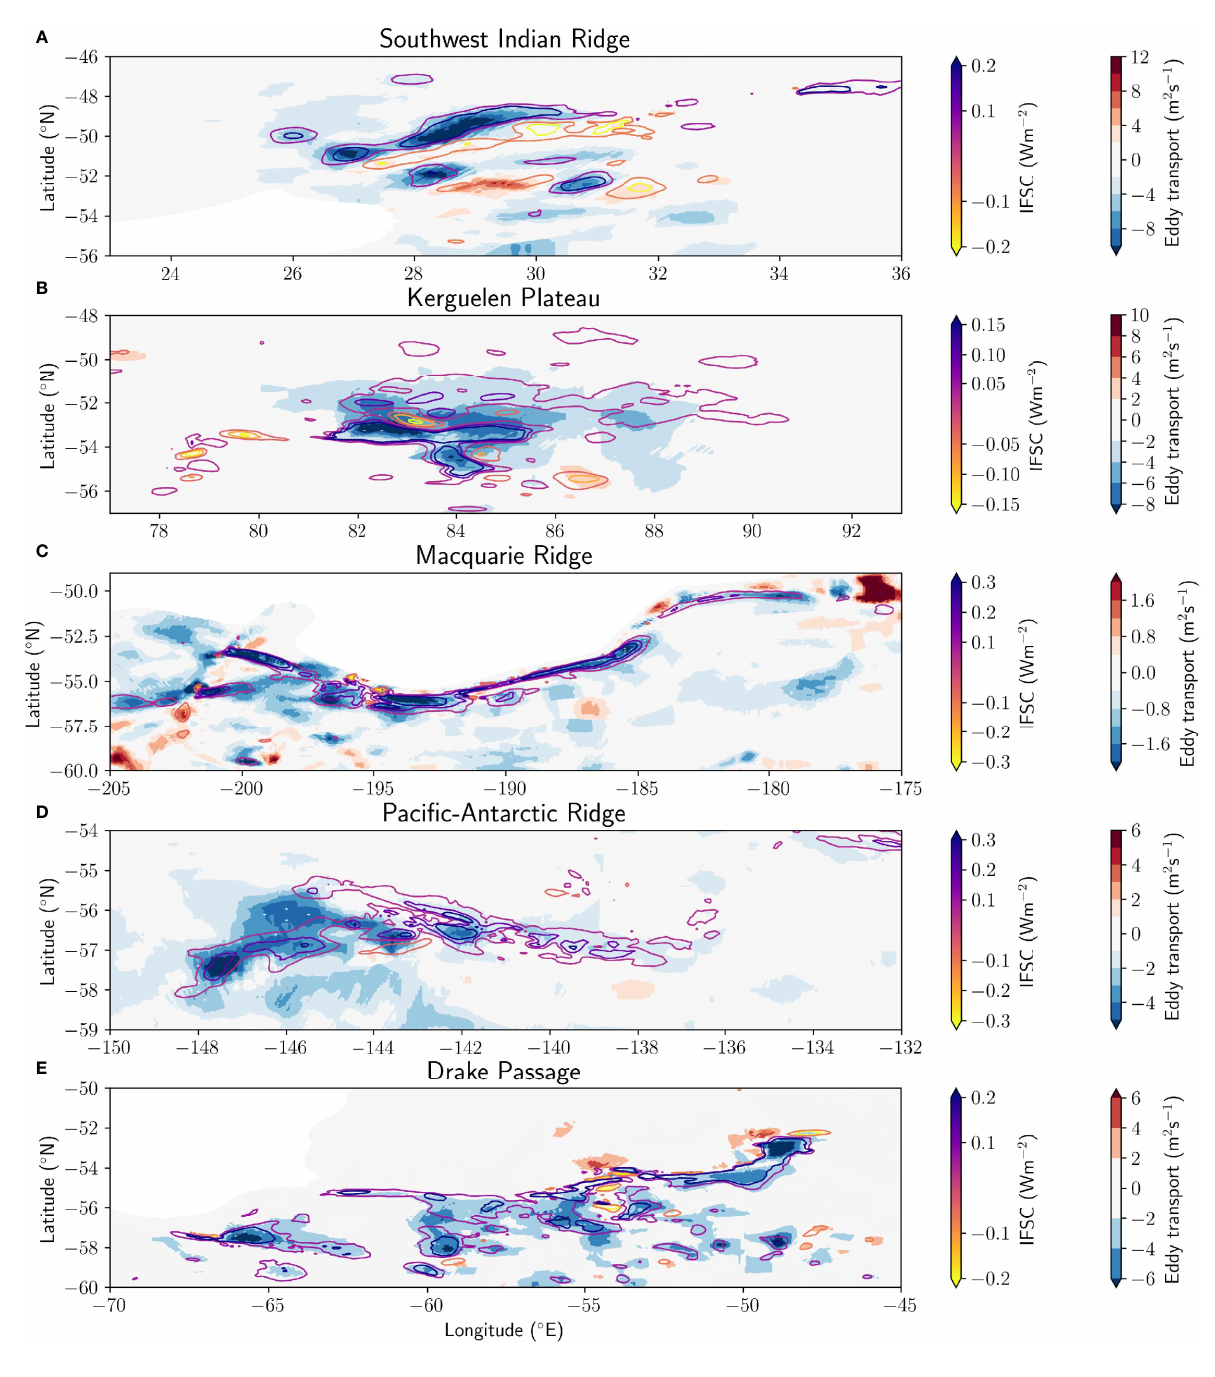
FIGURE 9 | Cross-contour eddy transport (background map, blue is southward cross-contour transport) and interfacial form stress energy conversion (IFSC) (coloured contours), integrated over the upwelling arm density range for each of the fi ve hotspots: (A) Macquarie Ridge, (B) Paci fi c-Antarctic Ridge, (C) Drake Passage, (D) Southwest Indian Ridge, and (E) Kerguelen